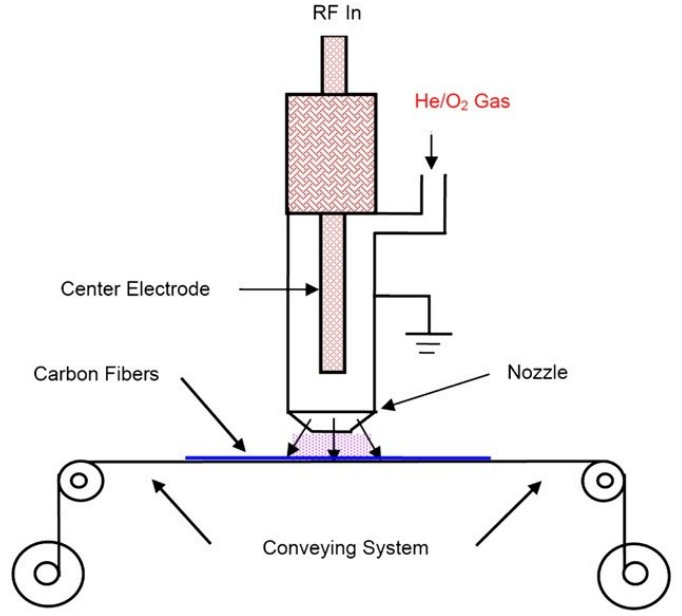
Figure 12. Plasma treatment on carbon fibres (reprinted with permission) [76].